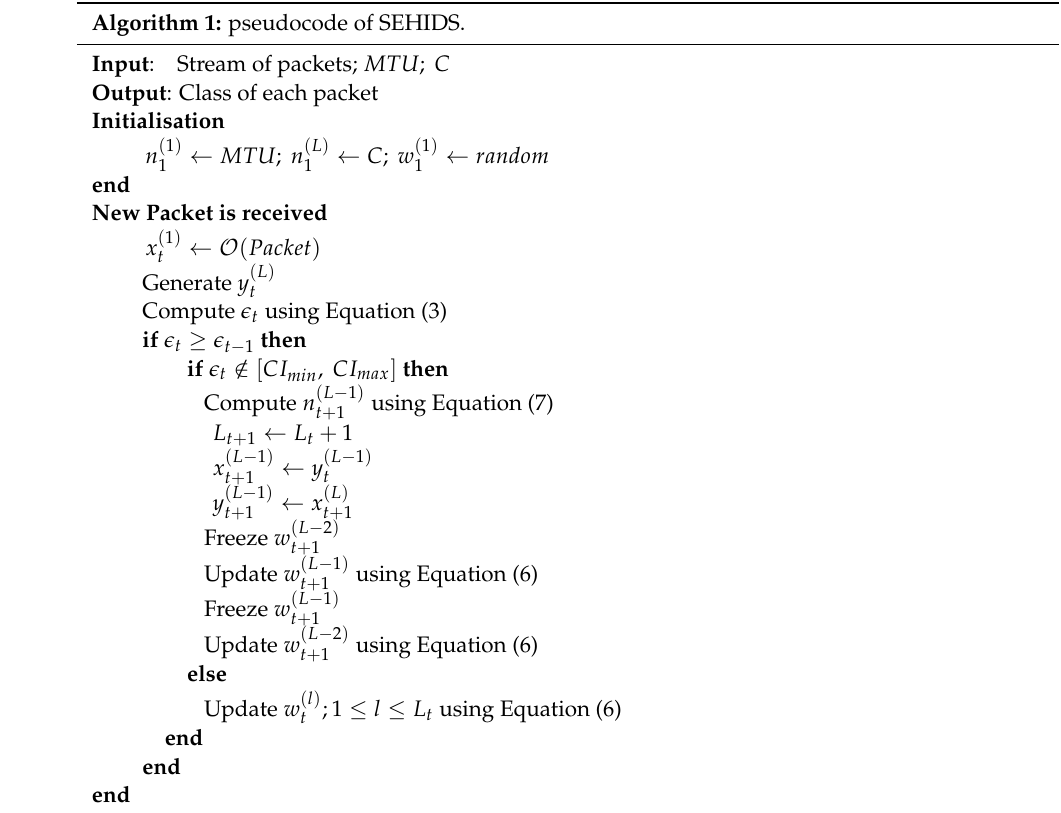
Algorithm 1. pseudocode of SEHIDS.